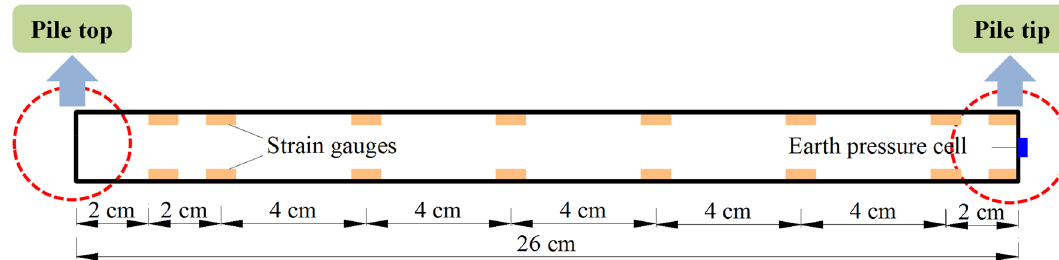
Figure 12. Layout diagram of test